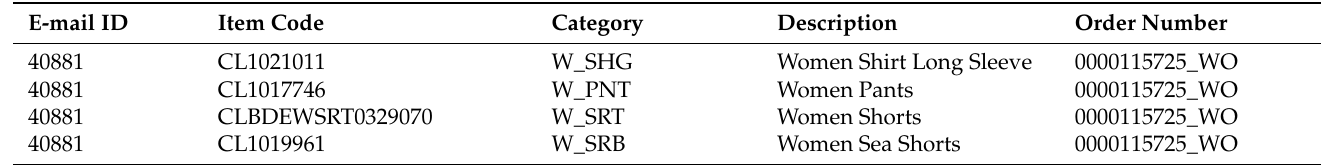
Table 7. The shopping details of the selected customer during the recommendation period.